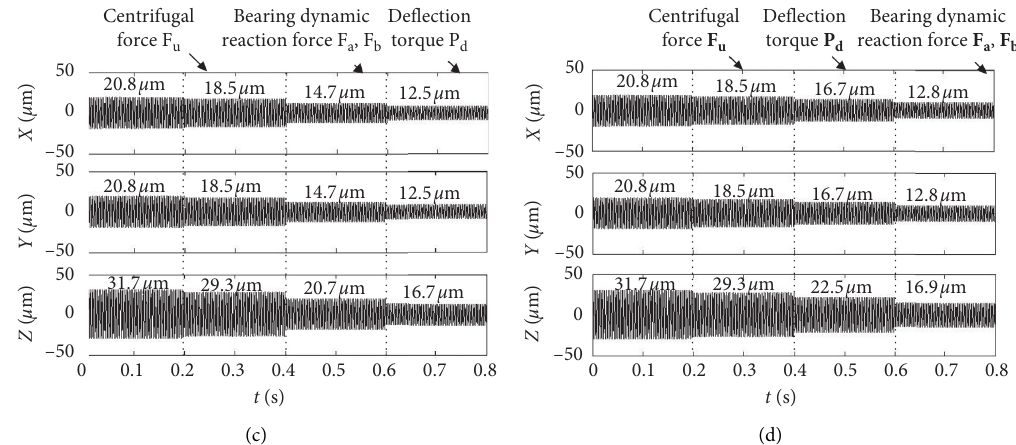
Figure 5: Cosuppression effectiveness of three interferences in different loading sequences.